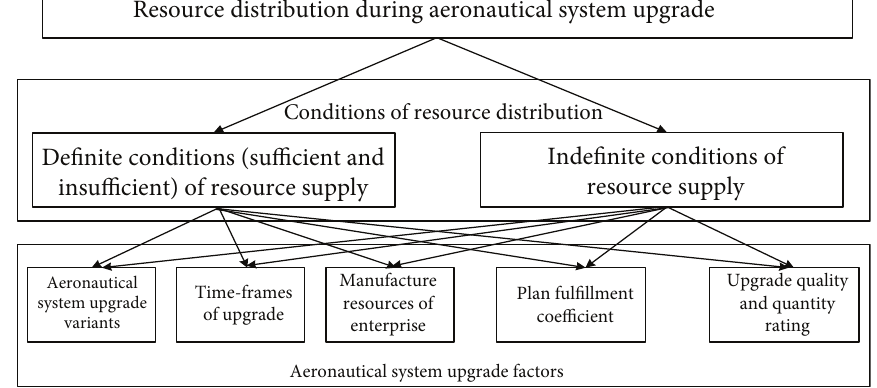
Fig. 2. Two classes of aeronautical system upgrade tasks under the condition of uncertain